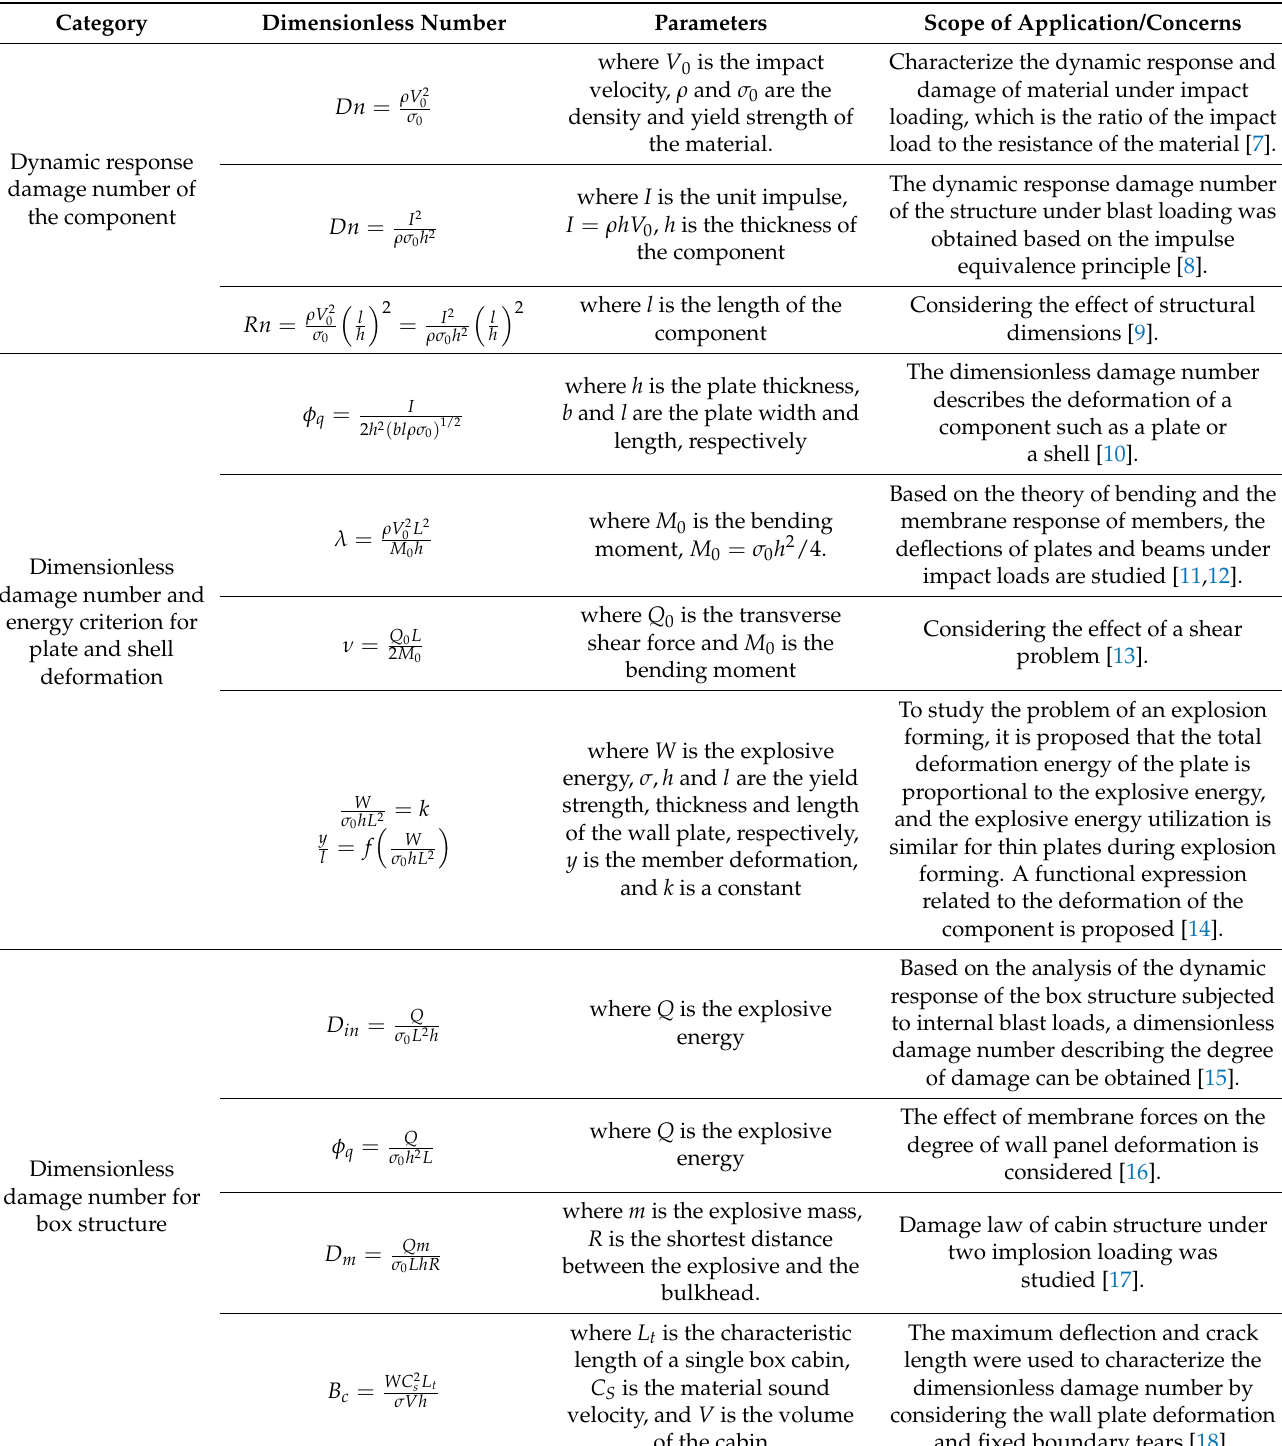
Table 1. Dimensionless numbers of dynamic